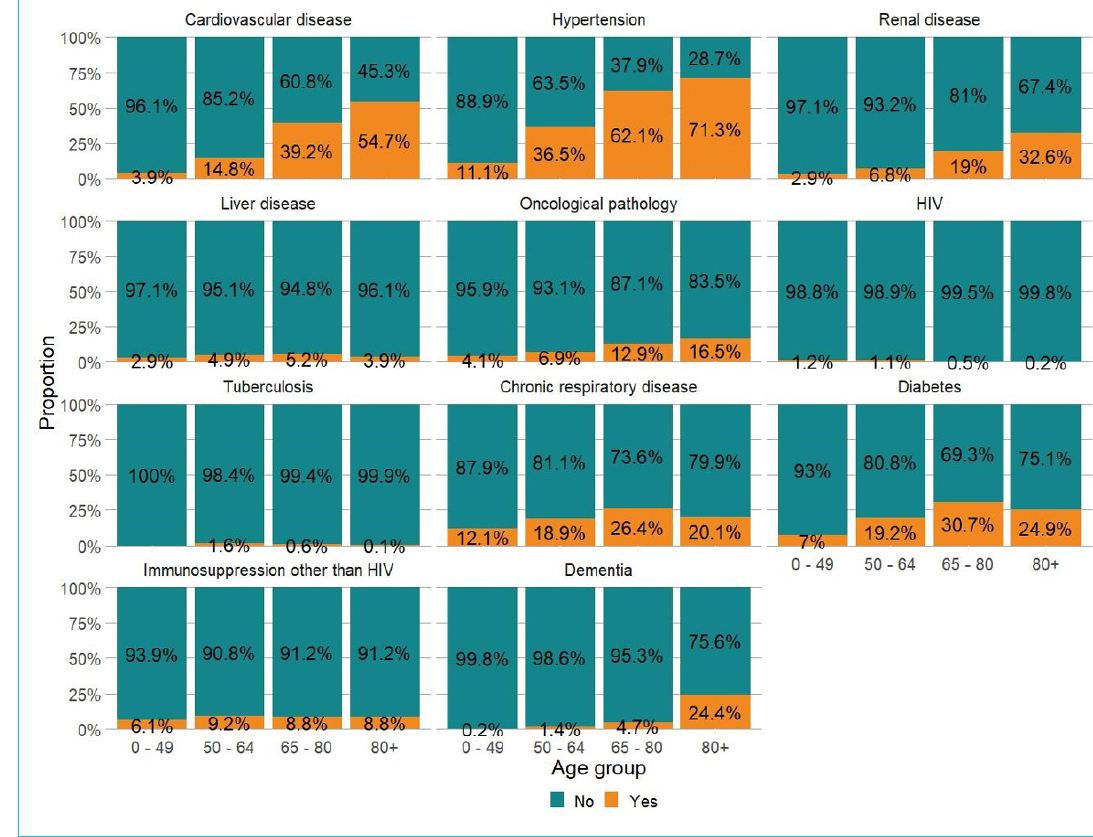
Figure 2: Proportions of patients with and without comorbidities in four age classes for 3590 adult patients hospitalised for COVID-19 in Switzerland. Data included up to 1 September 2020 (date of extraction 15 January 2021). Missing values have been excluded. Obesity and smoking are not presented in this figure, owing to a high proportion of missing values, 25% and 43%,